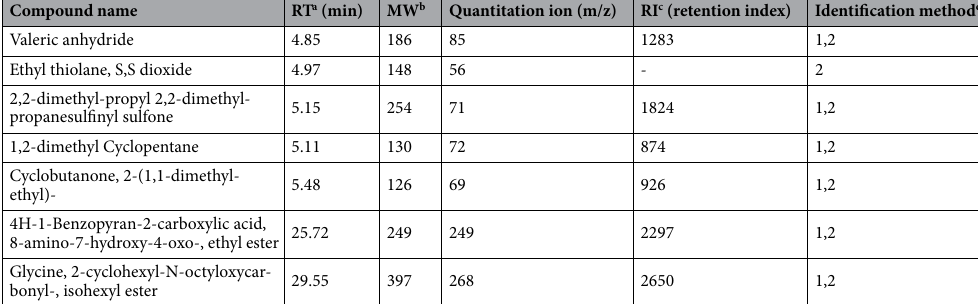
6 -C 24 n-alkanes on the